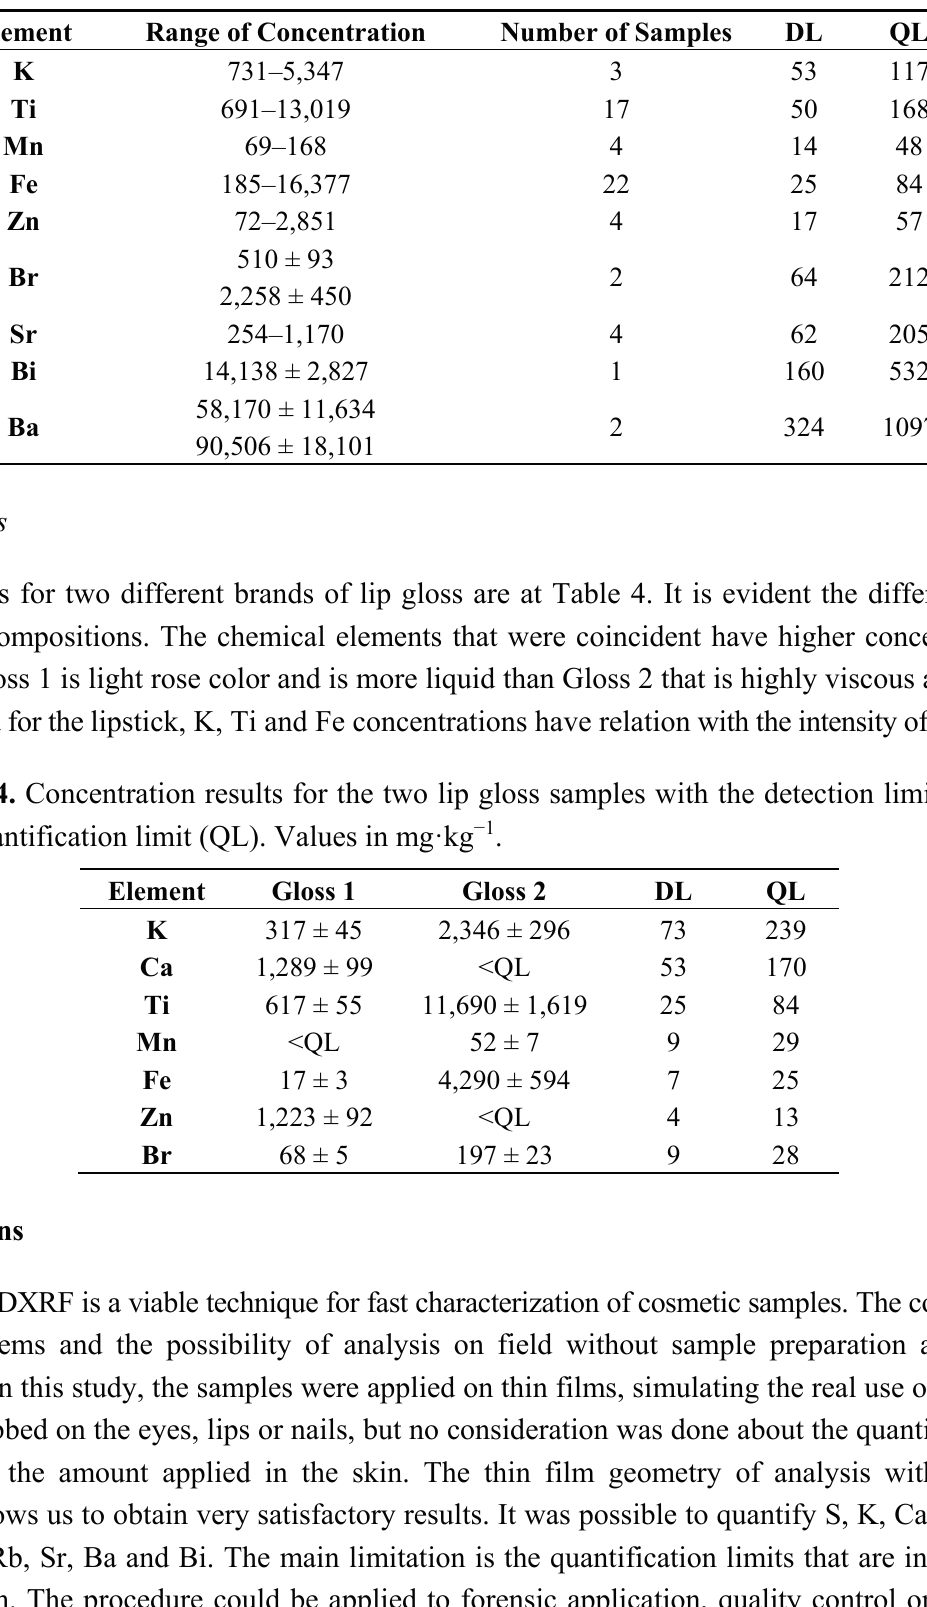
Table 3. Range of concentration results from lipstick samples with the detection limit (DL) and quantification limit (QL). Values in mg·kg − 1 .